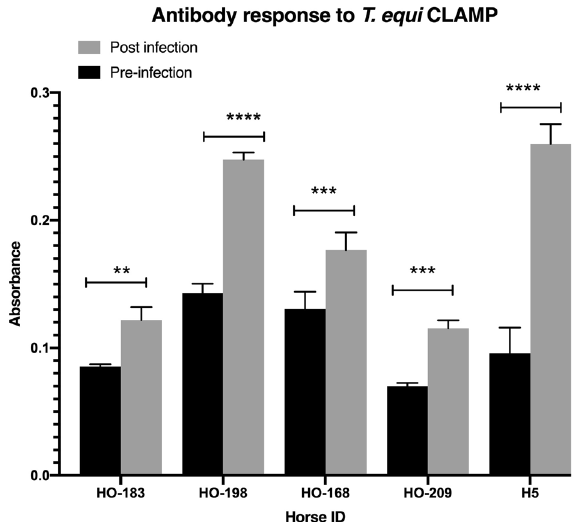
Figure 4. CLAMP elicits antibody responses in horses during infection with T. equi . CLAMP-specific antibodies are significantly present in horses after infection with T. equi (post- infection). ** p = 0.0014, *** p = 0.0002, **** p <